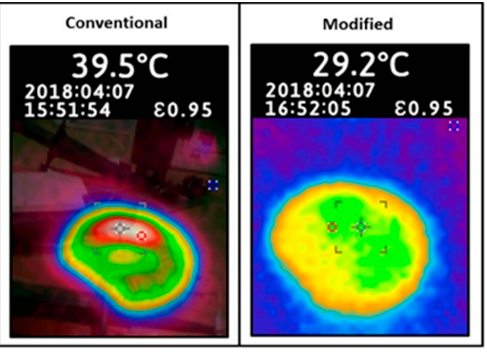
Figure 16. Toroidal transformers at 360° sectored winding, temperature comparison between the conventional and modified design of high-frequency link-based MV inverter systems.